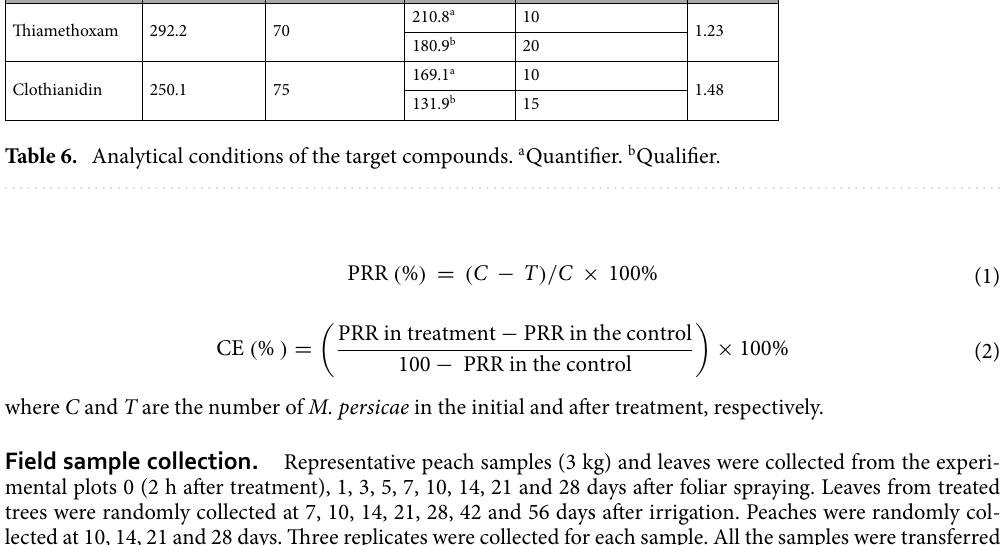
Table 6. Analytical conditions of the target compounds. a Quantifier. b Qualifier.